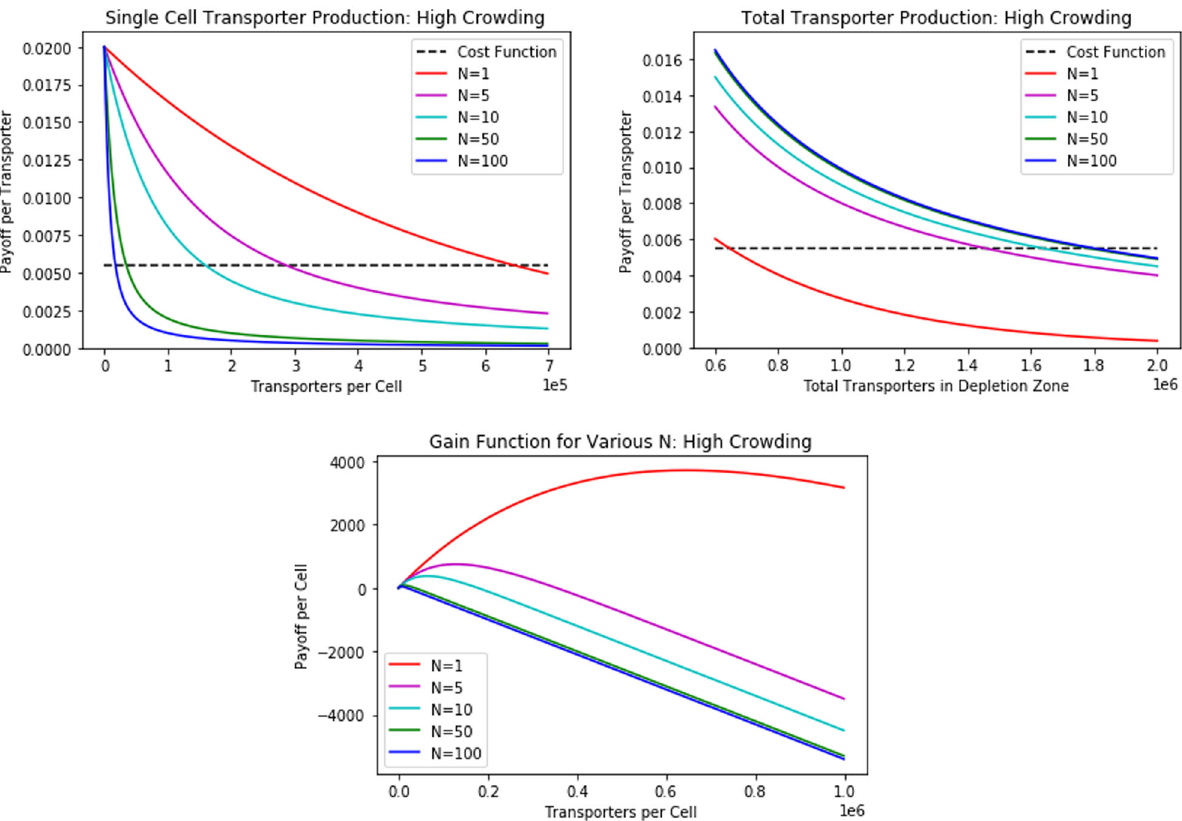
Fig. 1 How changing crowding (see Fig. 12) in fl uences transporter equilibria per cell, transporter equilibria per depletion zone, and payoff curve per cell for various N . At the team-optimum, the total number of transporters remain constant for various N (transporters per cell would adjust accordingly). At the ESS, the total number of transporters in the neighborhood increases while the number of transporters per cell decreases as a function of N (though this decrease is much lower than it would be if maintaining the team-optimum). The payoff to each cancer cell depends on both a unique payoff curve (determined by the number of competing cells in the neighborhood) and the location of the cell on this curve (determined by the ESS transporter count).